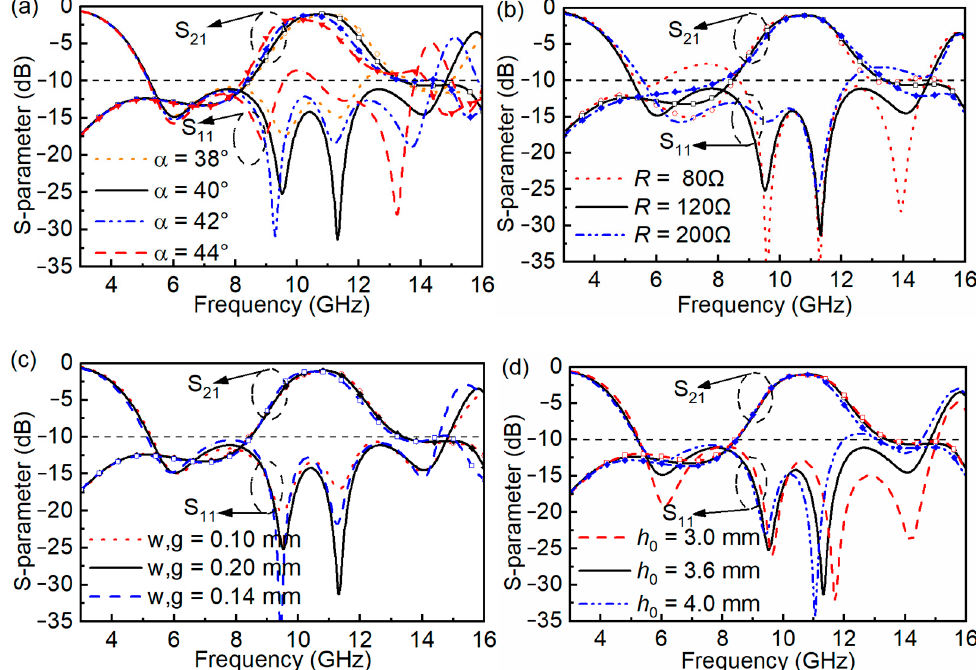
Figure 7. The result of S 11 and S 21 under different parameters. ( a ) Angle α of the band-patterned ring. ( b ) Lumped resistors R. ( c ) Width of strips w and gap g between each two strips. ( d ) Thickness h 0 of air between the FR4 substrates.